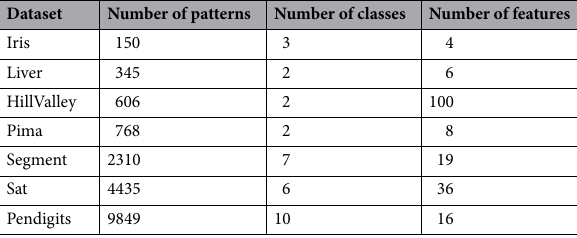
Table 3. Overview of the datasets in stationary experiments.